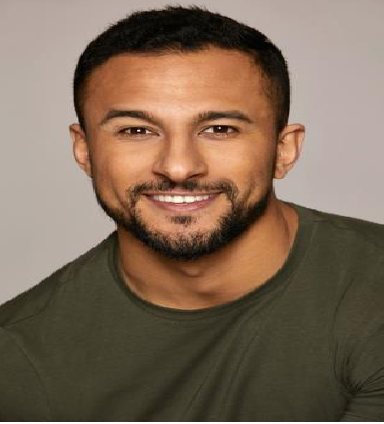
Figure 10. Consider one picture from our data set 1 [54].